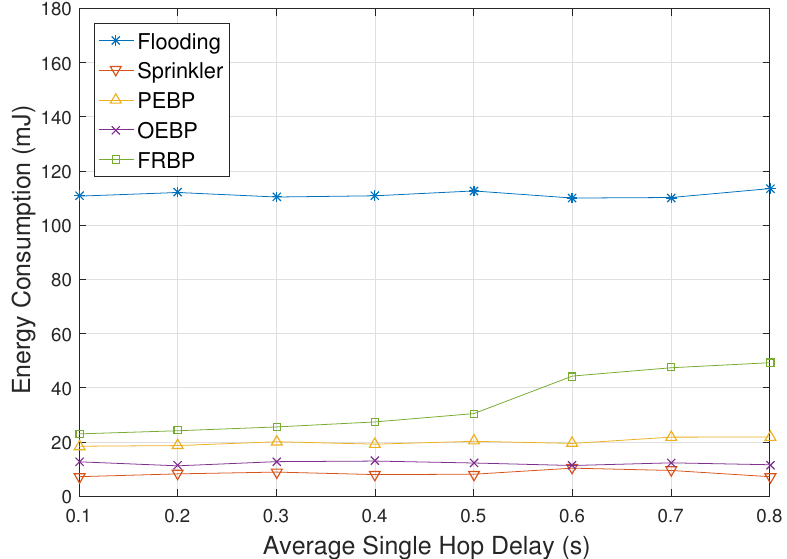
Figure 7. Energy consumption impacted by single hop